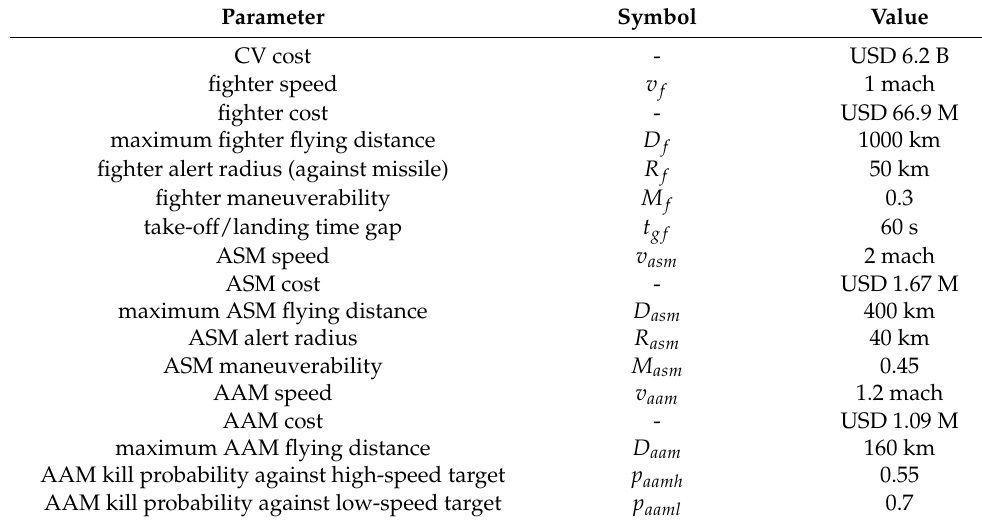
Table 4. Parameters of CV and fighters.